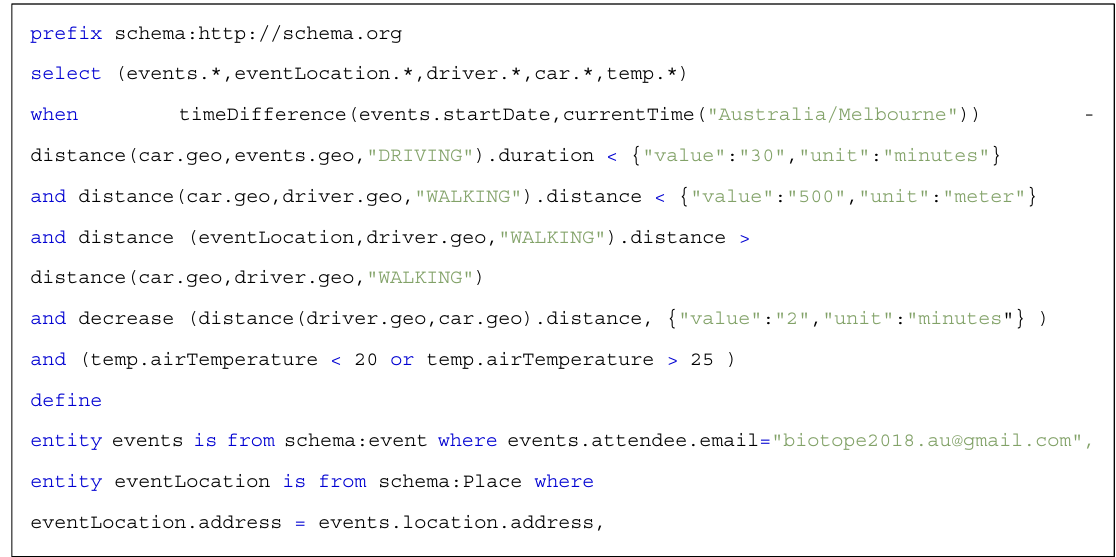
Figure 25. Pre-conditioning scenario workflow.